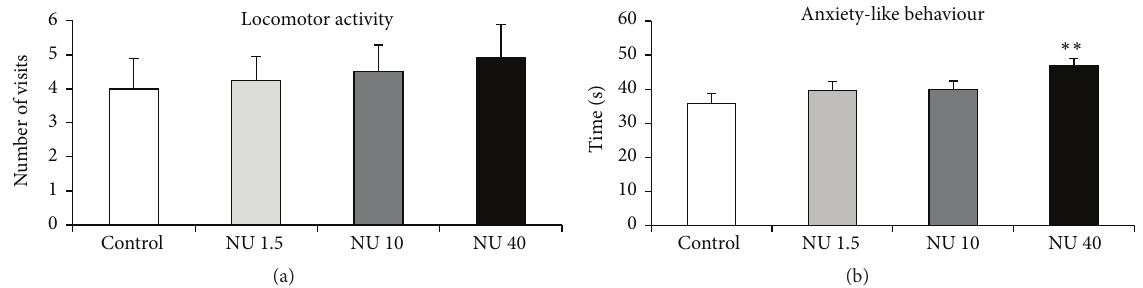
Figure 4: Locomotor activity and anxiety-like behaviour of male rats exposed to 1.5, 10, or 40mg ⋅ L −1 NU from birth for 9 months. (a) shows the number of visits to the closed arms of the elevated plus maze and reflects locomotor activity. (b) shows the time spent, expressed in seconds (s), in the closed arms of the elevated plus maze and reflects anxiety level. The data are presented as mean ± SEM; 𝑛 = 12 for each group; NU: natural uranium; ∗∗ 𝑝 < 0.01 , significant difference from control.